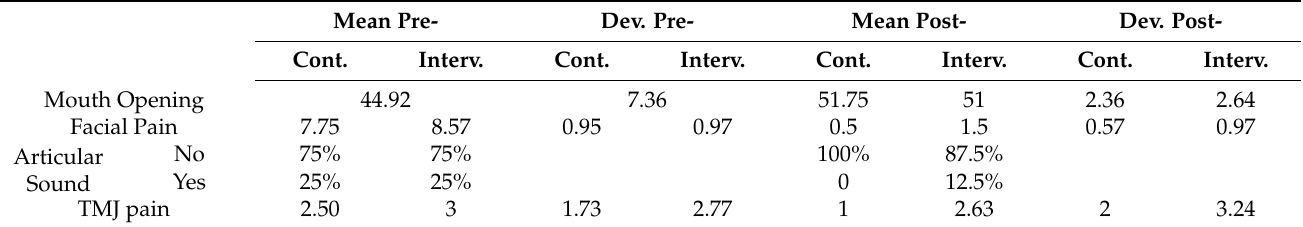
Table 3. Articular and facial pain.